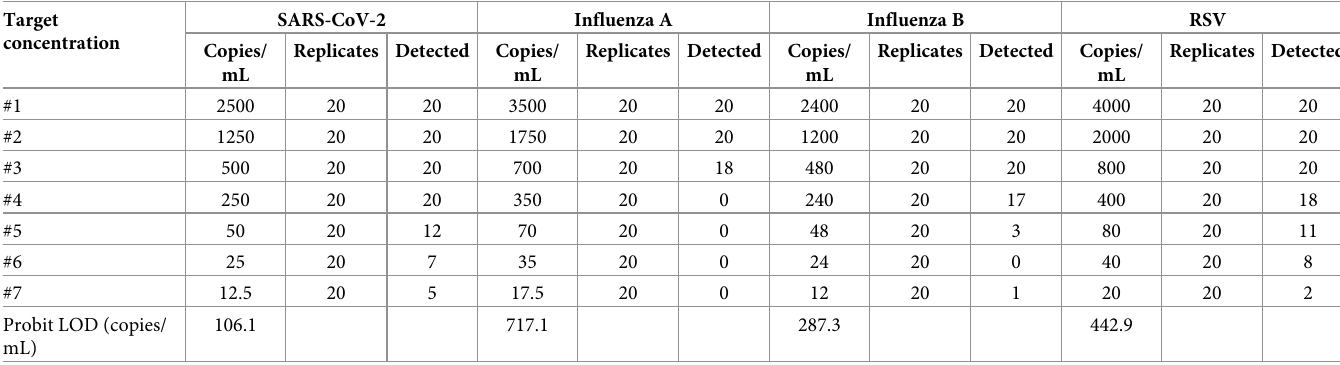
Table 5. Analytical sensitivity evaluation results of the Kaira assay. Target